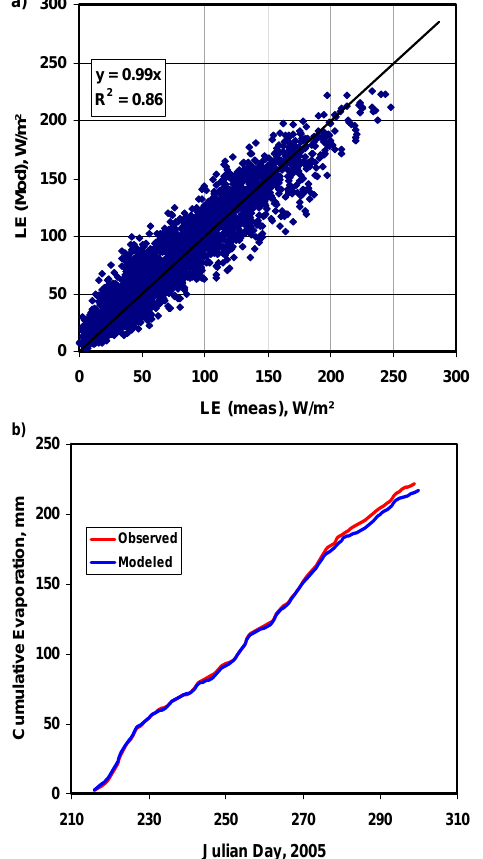
Figure 9. The measured and calculated hourly evaporation rates for 4 consecutive days on Quill Lake (Aug. 29 – Sep.1, 1993).